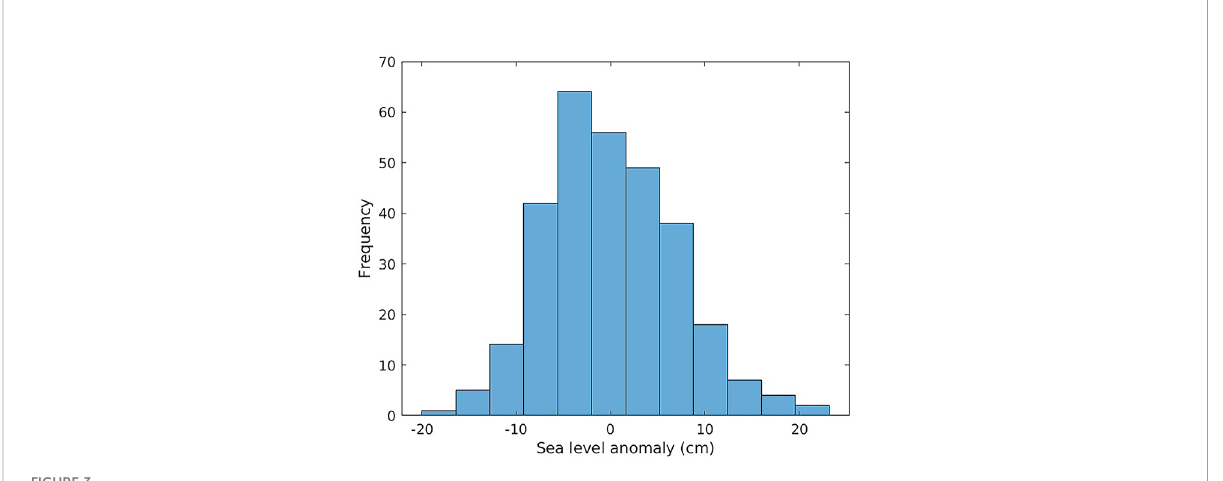
FIGURE 3 Histogram of monthly mean sea level anomalies (cm). Mean values of all tide gauge stations shown in Figure 1 are